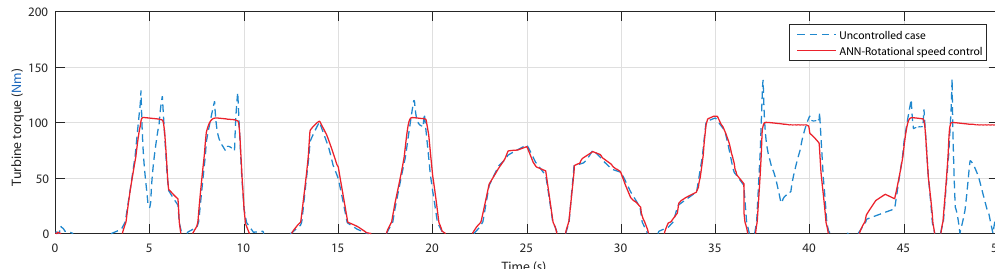
Figure 29. Turbine torque for uncontrolled case and ANN-based rotational speed control.